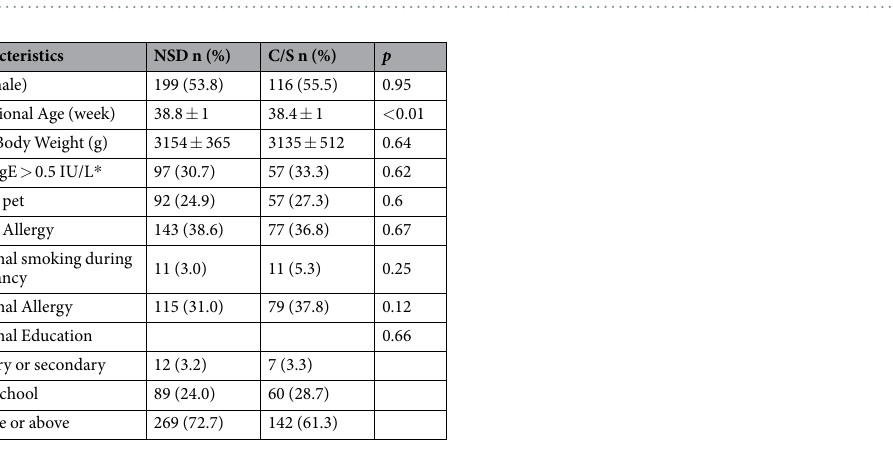
Figure 1. Flow chart of the birth cohort study: demonstrating the number of participants with detailed quantities of various samples tested and valid questionnaire information. * Nasopharyngeal swab was performed at 1 month of age.